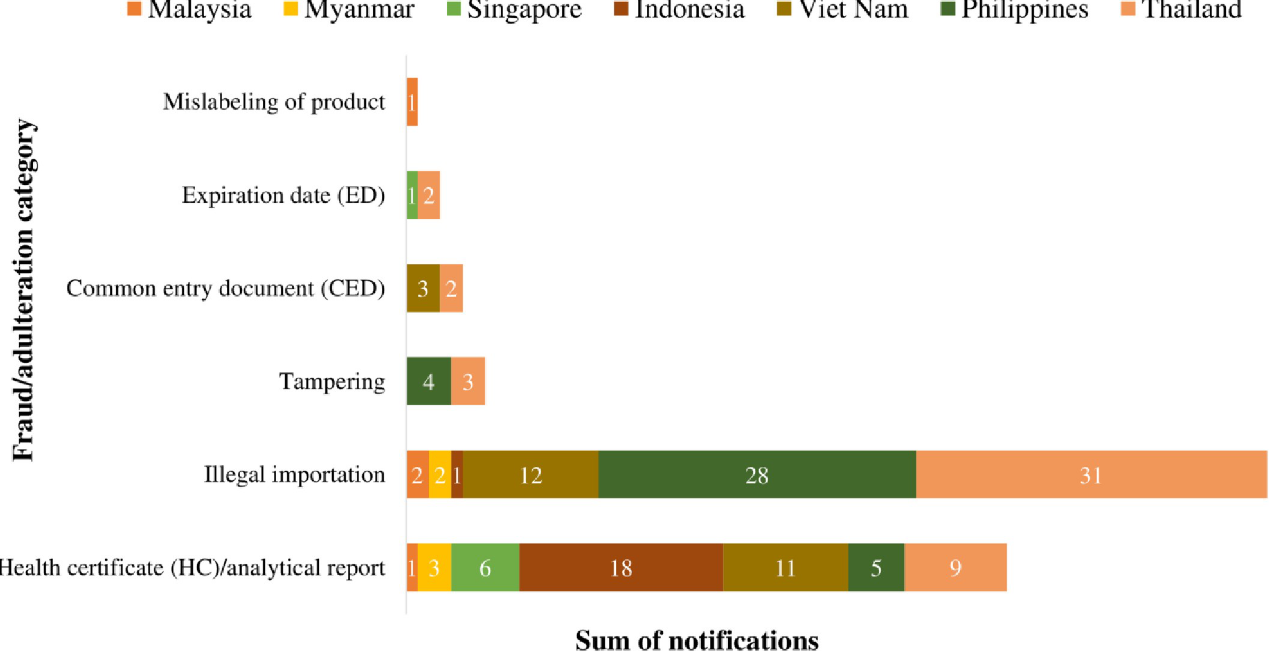
Fig 5. Summary of notifications in RASFF on food/feed product s from ASEAN countries by fraud/adulteration category (2000 and 2020).